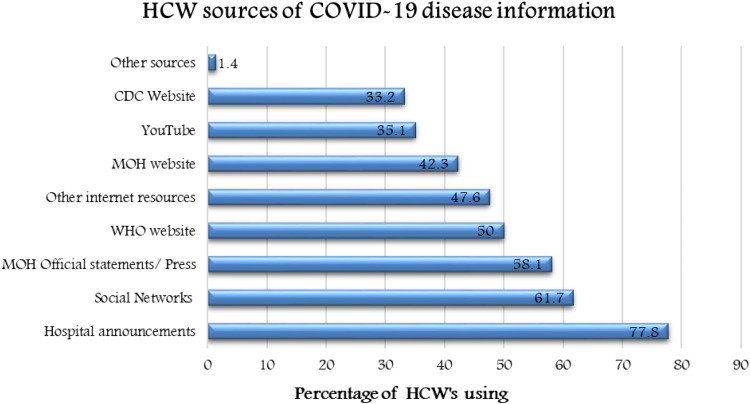
HCW sources of COVID-19 disease information.